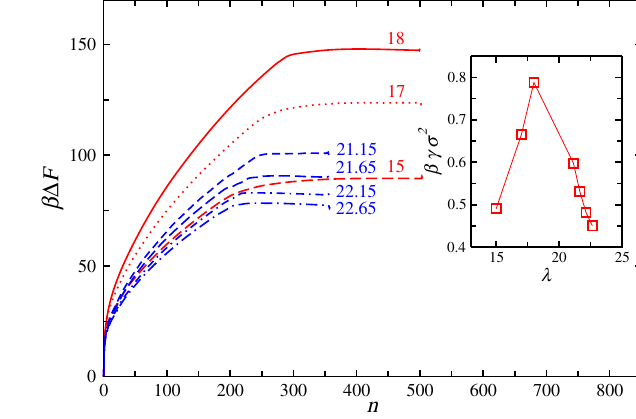
FIG. 10. Excess free energy at coexistence. The free-energy landscape [ β F ð n Þ ] is a function of the number of crystalline particles n along the coexistence line at different values of λ . The bulk fluid phase is at n ¼ 0 , while at some n ¼ n (cid:2) , the system reaches a plateau, which corresponds to a planar fluid-crystal interface. Red curves are for values of λ where bcc is the stable crystalline phase, while blue curves are computed along the melting line of the dc phase. Red square symbols in the inset show the interfacial contribution computed as βγσ 2 ¼ ½ β Δ F ð n (cid:2) Þ − β Δ F ð 0 Þ(cid:3) = 2 S , where S is the area of the planar